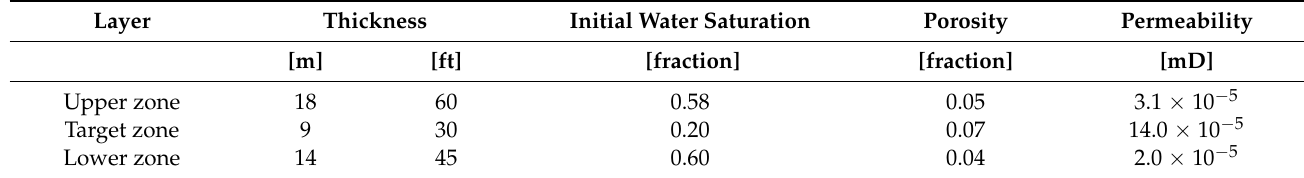
Table 1. Reservoir horizon